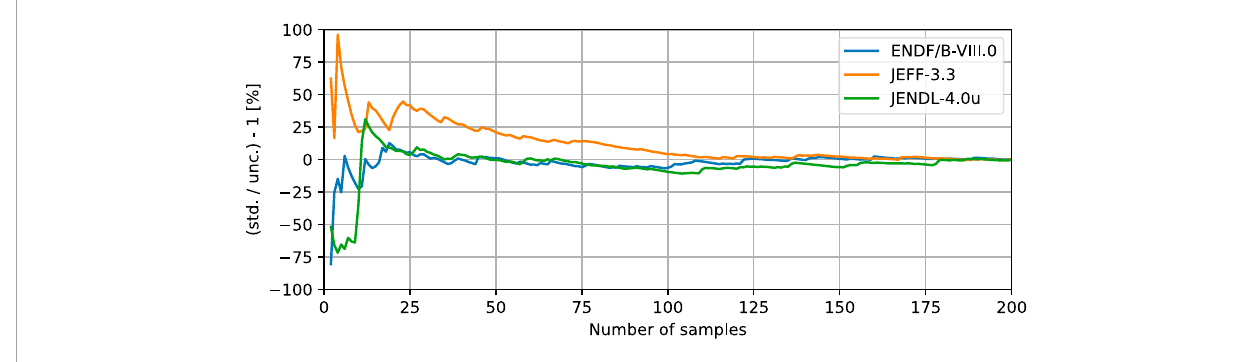
FIGURE 4 Convergence of the standard deviation (std.) of the discharge concentration of 244 Cm with the number of cross-section samples for the actinides. The values are normalized over the best prediction of the concentration uncertainty of 244 Cm (unc.), i.e., the standard deviation computed with 200 cross-section